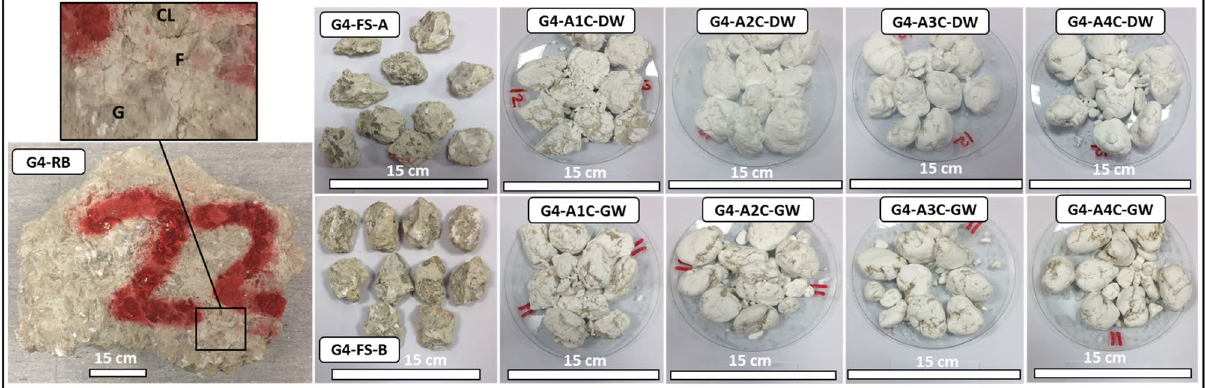
Figure 6. Representative evaporitic rock block (G4–RB; Group 4, Rock Block) and slake durability test samples cycled with distilled water and groundwater (1st–4th cycles). G1-FS-A represents Group 4, fresh sample, sample A, G4-A1C-DW to G4-A4C-DW after 1st–4th cycles with distilled water. G4-FS-B represents Group 4, fresh sample, sample B, G4-A1C-GW to G4-A4C-GW after 1st–4th cycles with groundwater. G = Gypsum, F = Fracture, CL = Clay.